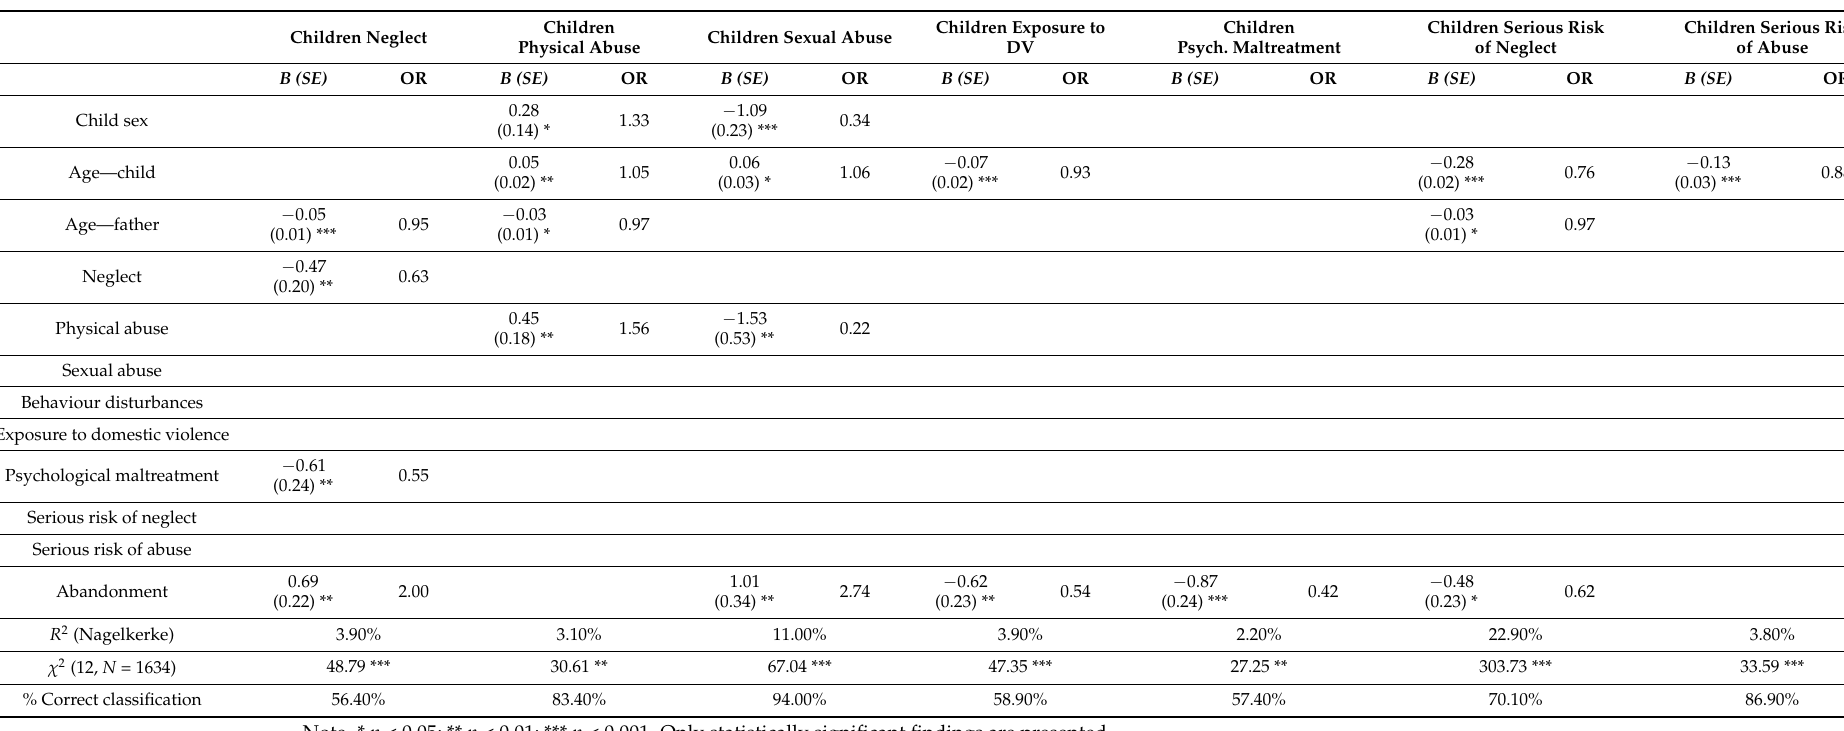
Table 3. Fathers’ child maltreatment histories predicting child maltreatment in